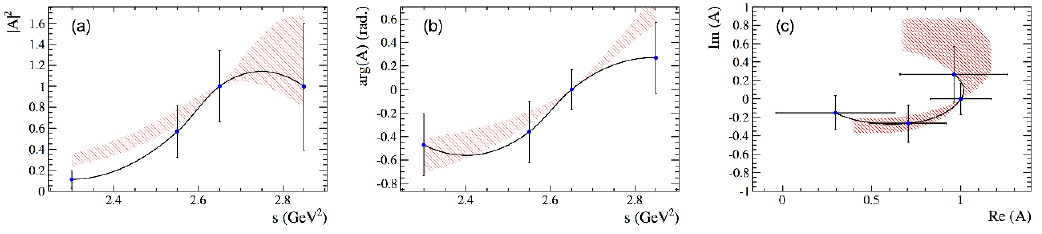
Figure 8 . Magnitude-squared (a), phase (b) and Argand diagram (c) of the quasi-model- independent a 1 (1640) lineshape. The (cid:12)tted knots are displayed as points with error bars and the black line shows the interpolated spline. The Breit-Wigner lineshape with the mass and width from the nominal (cid:12)t is superimposed (red area). The latter is chosen to agree with the interpolated spline at the point < ( A ) = 1, = ( A ) =